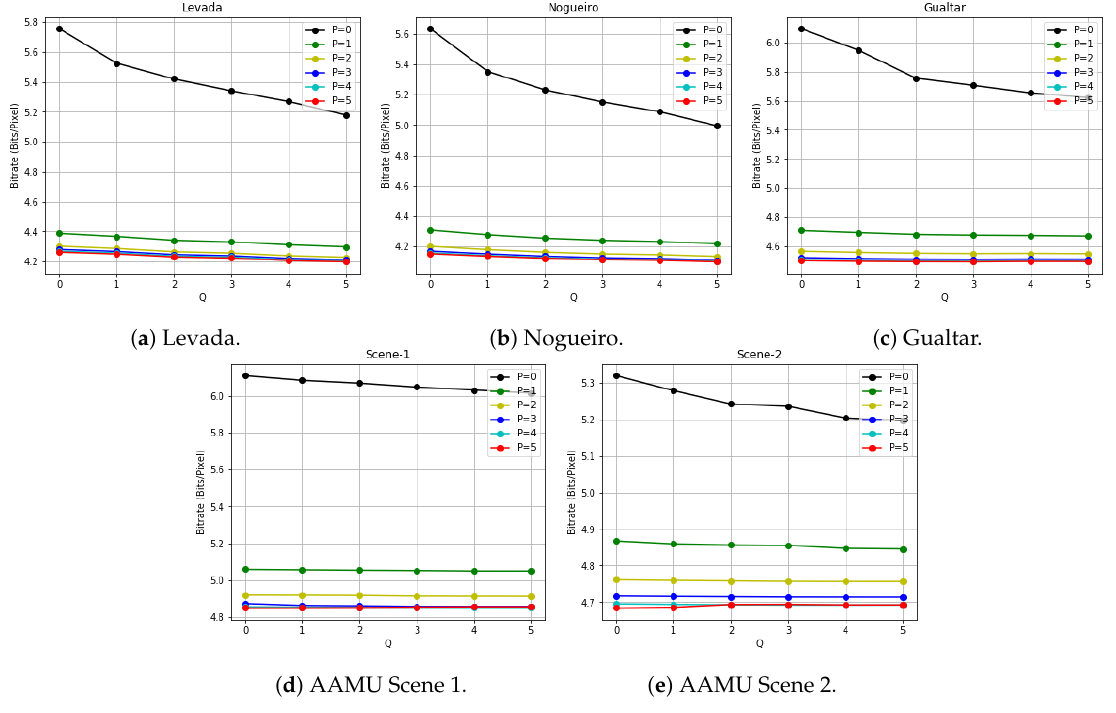
Figure 5. Bitrates over five datasets for different P and Q combination.